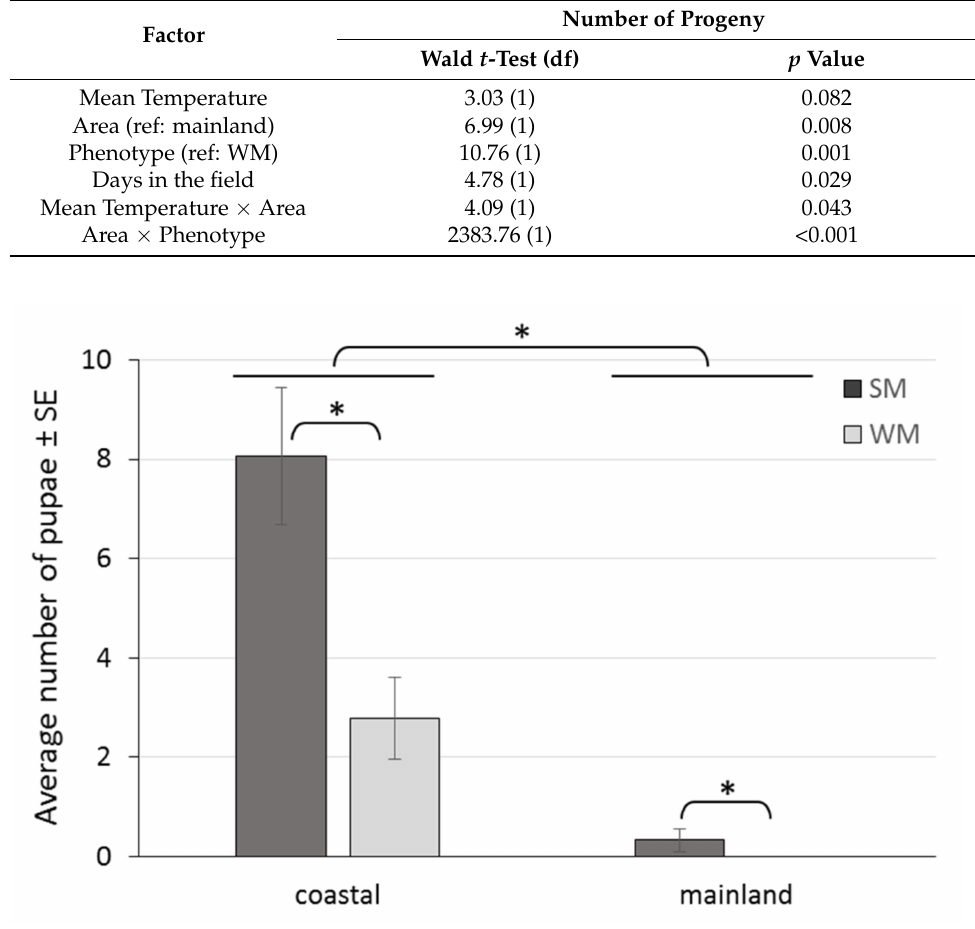
Figure 8. Offspring production by SM and WM females in field conditions of a coastal area (Volos) and a mainland area (Naousa) from 1 November 2019 to 31 May 2020. Values within the chart below the asterisk differ significantly ( p <